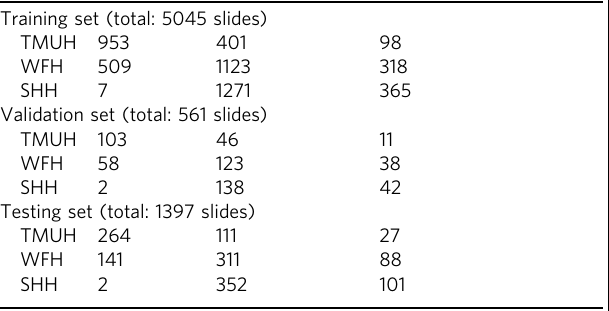
Table 2 Case numbers of digital slides collected from TMUH, WFH, and